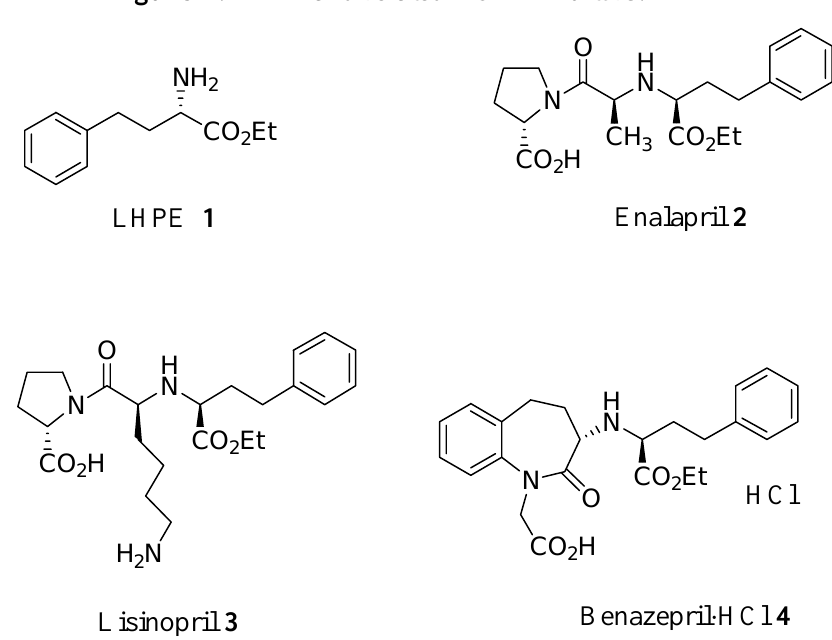
Figure 1 . LHPE and related ACE